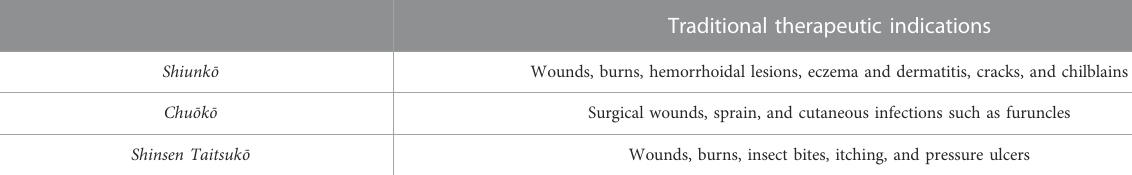
TABLE 2 Kampo ointments and their therapeutic indications regarding dermatology.